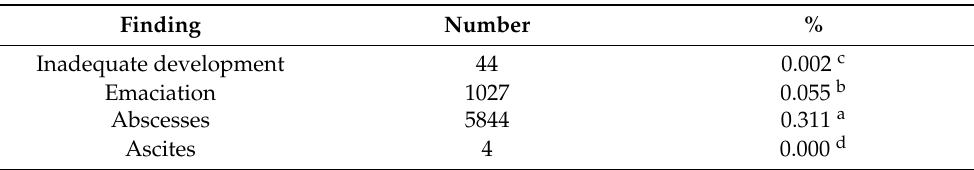
Table 5. The occurrence of generalized changes in rabbits (n = 1,876,929) after slaughter at the